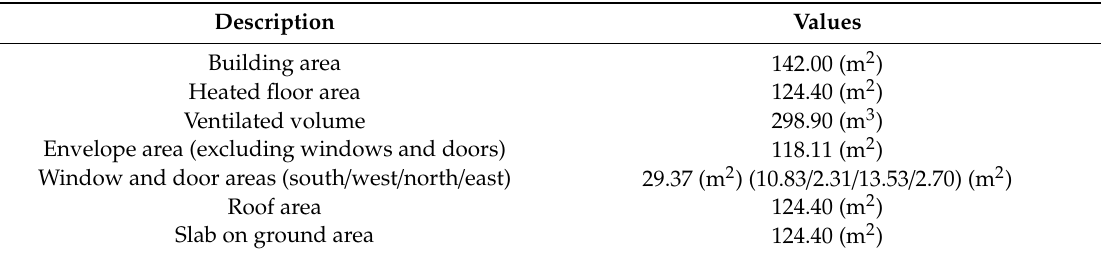
Table 2. Key details of the studied building.